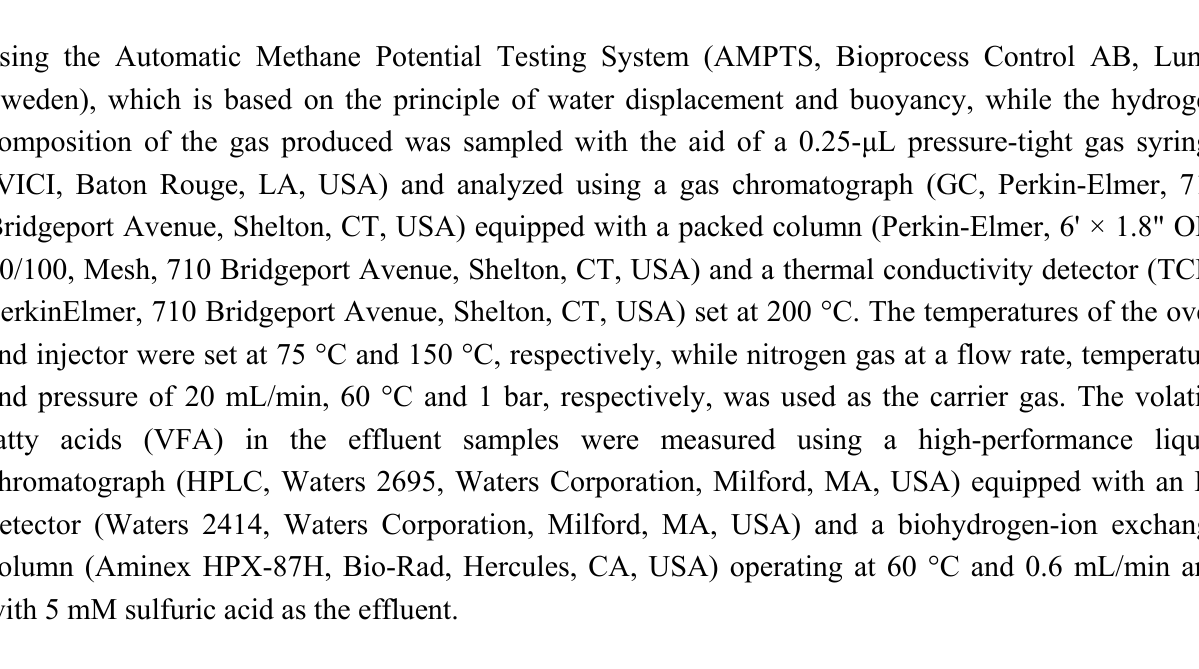
Table 7. Measured characteristics of fruit wastes. TS, total solid.